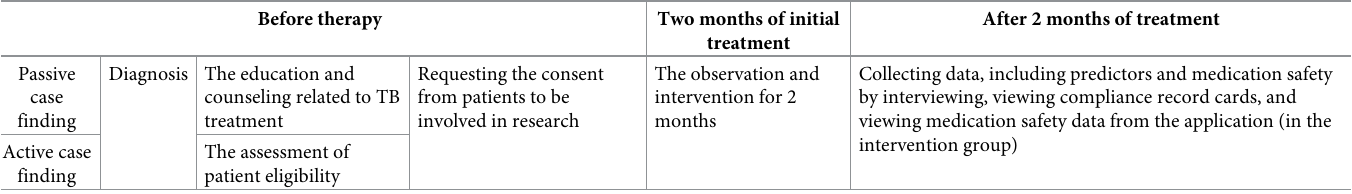
Table 2. The flow of the quasi-experimental study.